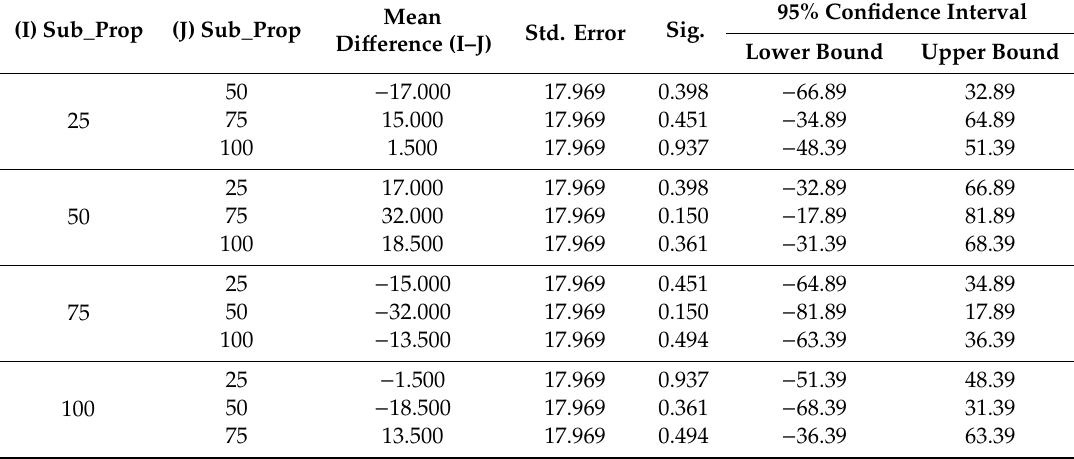
Table A4. Multiple Comparisons by the Least Significant Di ff erence (LSD) method for maximum power densities (mW / m 3 ) of the MFCs with the cathode electrodes submerged at the proportions of 25%, 50%, 75%, and